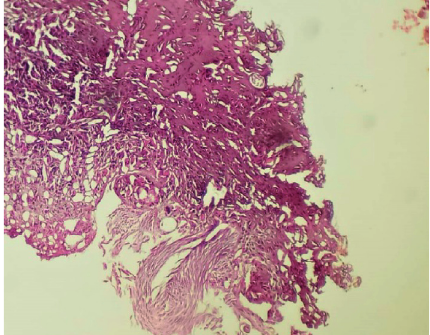
Figure 5: Granulomatous inflammatory reaction and not viable bilharzia egg. Hematoxylin and eosin x 100 (image of Professor Dial, head of the pathological anatomy laboratory of HOGIP).